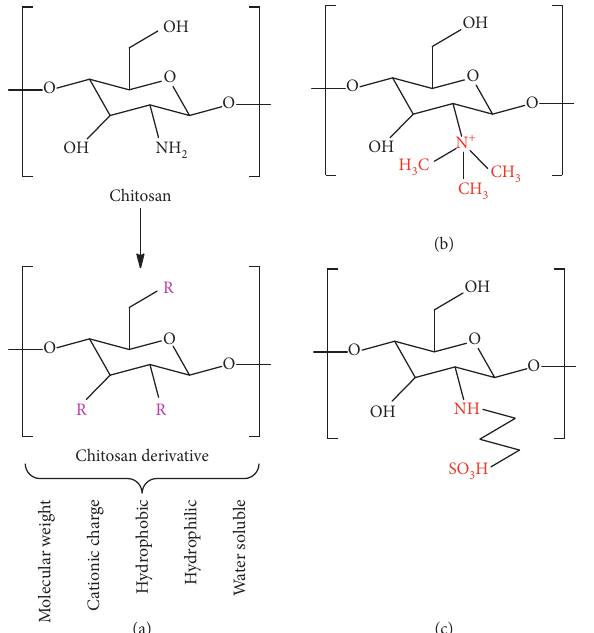
Figure 4: Chemical structures of (a) chitosan, (b) trimethyl chitosan (TMC), and (c) sulfonated chitosan (SCS). Chitosan derivatives with different properties can be prepared by modification at R ( R quaternary ammonium, sulfonation, hydroxyalkyl, alkyl, and